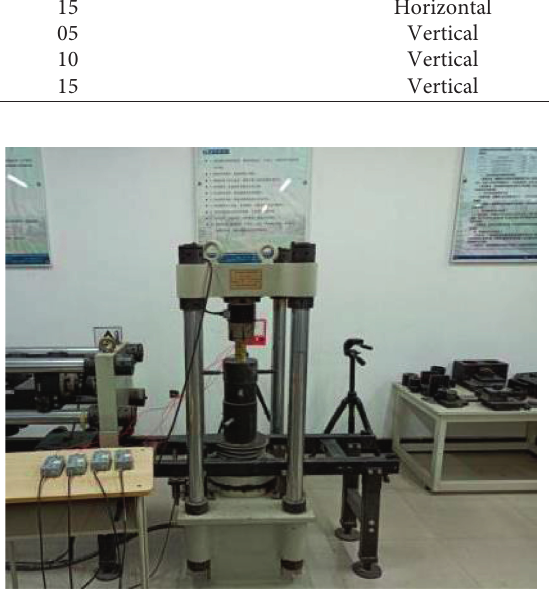
Figure 2: Site of the acoustic emission monitoring experiment under uniaxial compression.